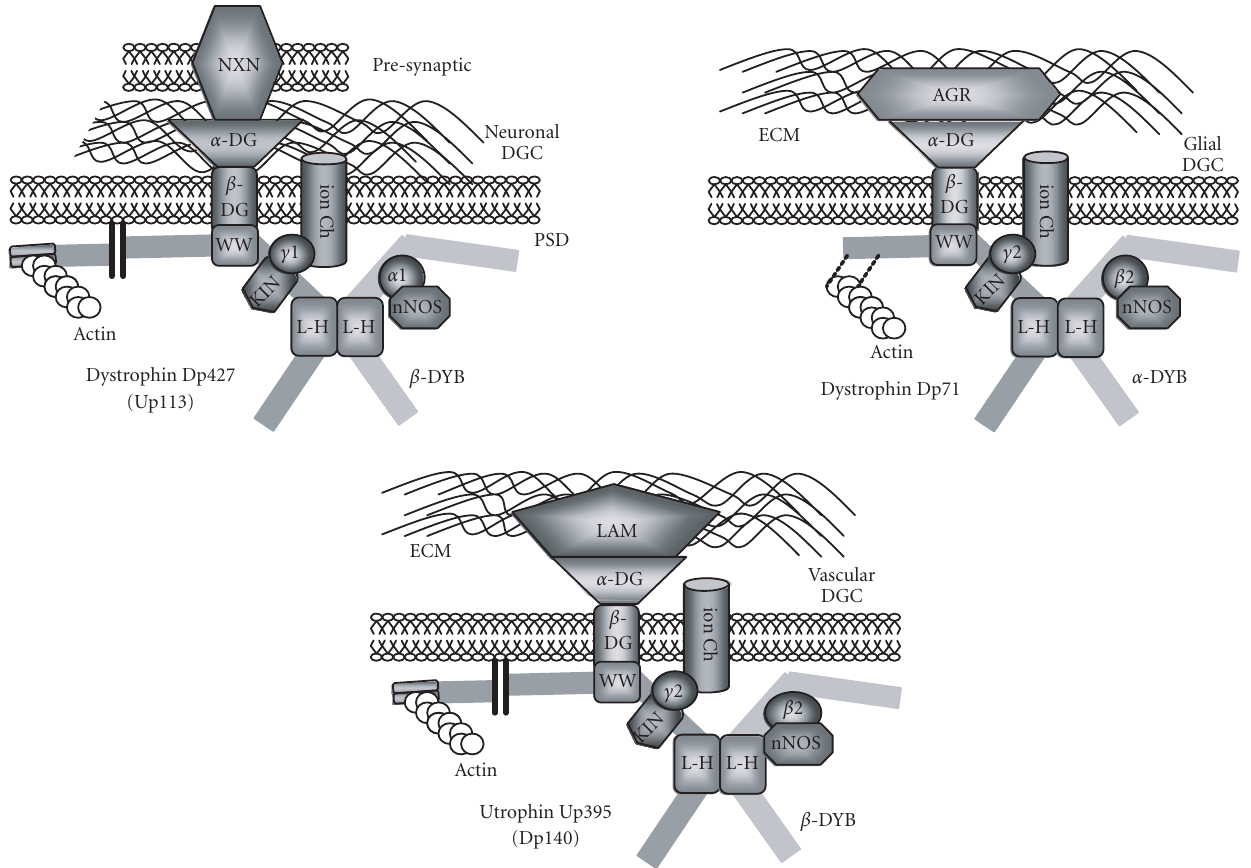
Figure 3. Variations in the brain dystrophin-glycoprotein complex. Schematic representation of the established members of established dystrophin- glycoprotein complexes (DGC), and their associations with other peripheral proteins. Shown are a neuronal complex, a glial complex, and a general vascular complex. A dystrophin or utrophin isoform links to the α / β -dystroglycan (DG) backbone and a dystrobrevin (DYB) isoform. An association with the extracel- lular matrix (ECM) by α -dystroglycan is maintained through agrin (AGR) or laminin (LAM). In neurons, α -dystroglycan is associated with neurexin (NXN), linking the presynaptic membrane (PRE) to the postsynaptic density (PSD). Other α -dystroglycan ligands are represented by agrin (AGR) and laminin (LAM). Syntrophin isoforms ( α 1, β 2, γ 1, or γ 2) recruit neuronal nitric oxide synthase (nNOS) to the complex, as well as other nonestablished